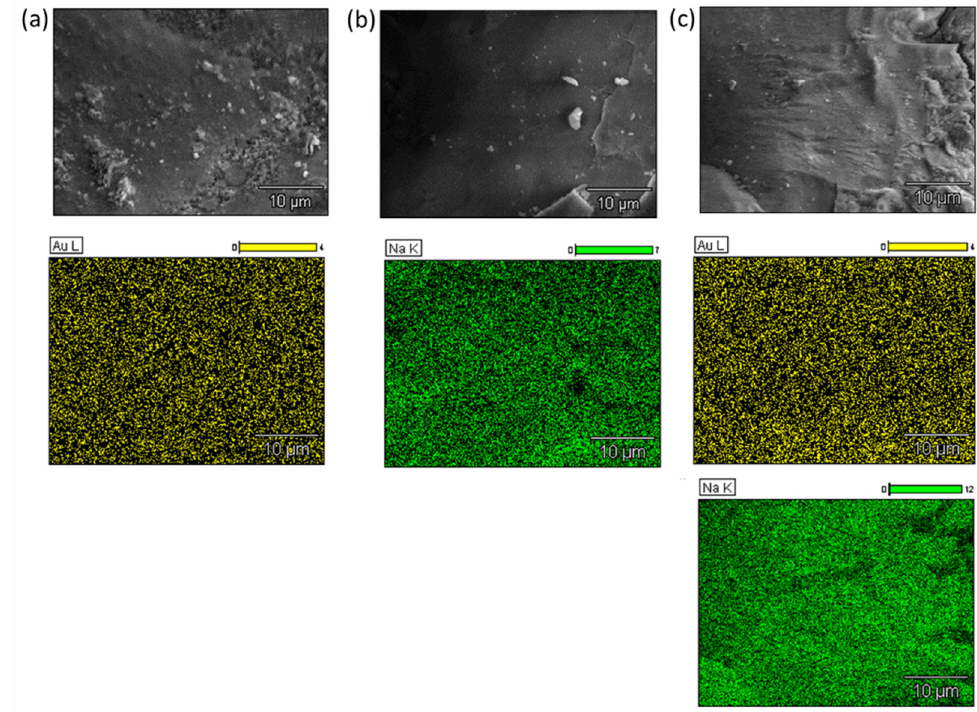
Figure 8. SEM images and corresponding distribution maps (EDX) of Au and Na on the surface of ( a ) Au/CZ, ( b ) Au + 0.3 at% Na/CZ and ( c ) 0.3 at% Na/CZ.